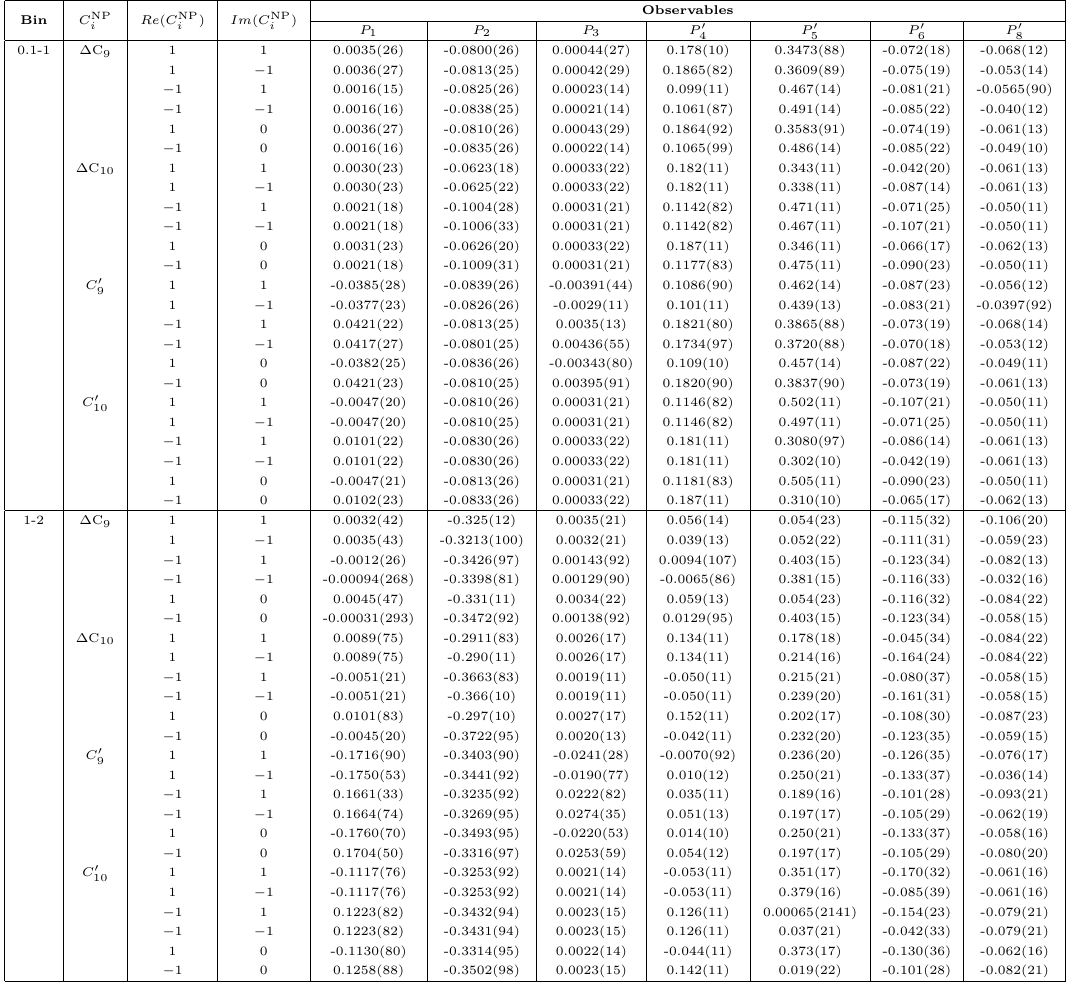
Table 24 . The dependence of the optimized observables corresponding to B ± → ρ ± ll on the real and imaginary parts of the NP WC’s ∆ C few benchmark values of the real and imaginary parts of the corresponding